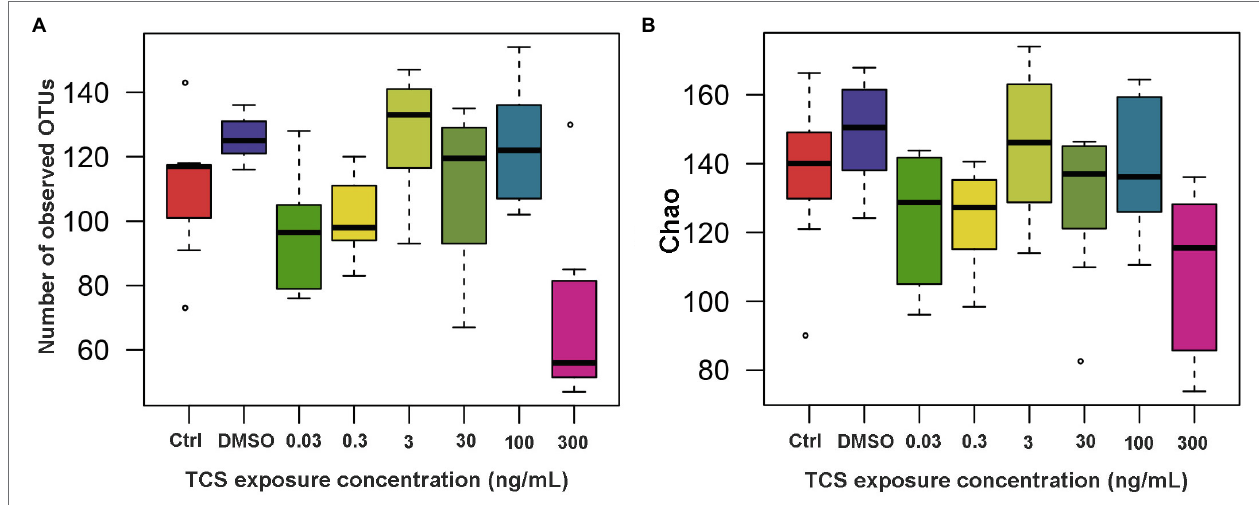
FIGURE 1 | The alpha-diversity ( A : number of observed OTUs; B : Chao index) of microbiota in zebrafish with different concentrations of TCS exposure compared to the control group (DMSO group) at the OTU level. OTUs, Operational Taxonomic